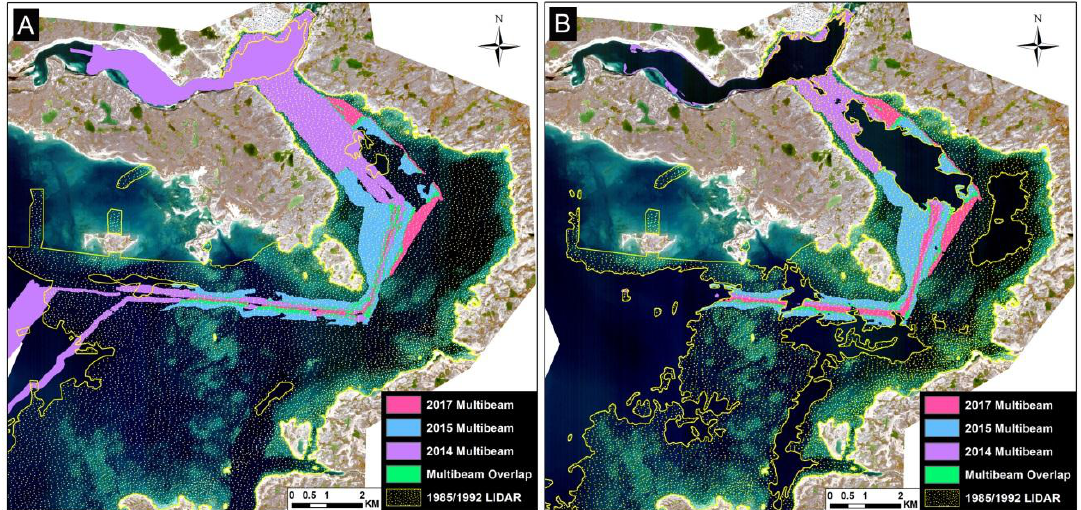
Figure 2. ( A ) Distribution of multibeam survey data (2014, 2015 and 2017) and LiDAR surveys (1985, 1992) over the study site. ( B ) Hydrographic survey data of ≤ 20 m water depth used for accuracy assessment. Imagery © 2015, DigitalGlobe, Inc.